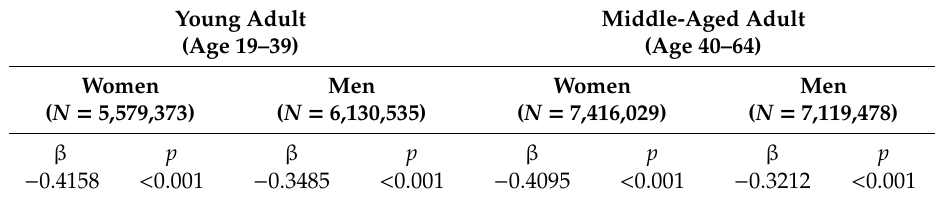
β : standardized coe ffi cient of linear regression